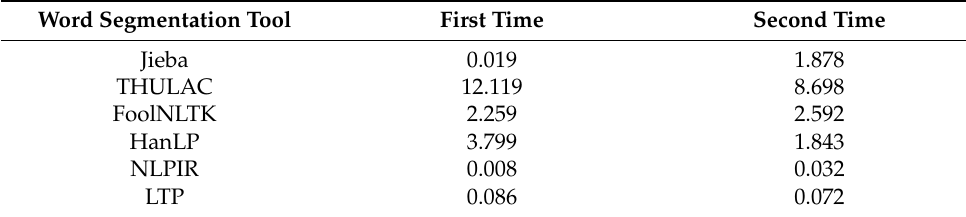
Table 1. Test time of different word segmentation methods. Word Segmentation Tool